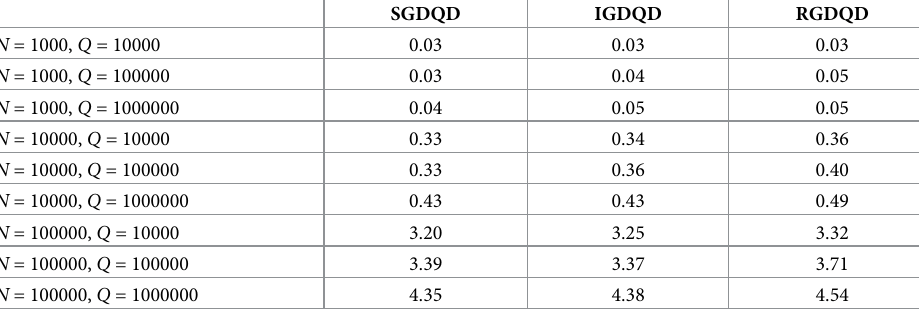
Table 16. Average solution time of the proposed algorithms